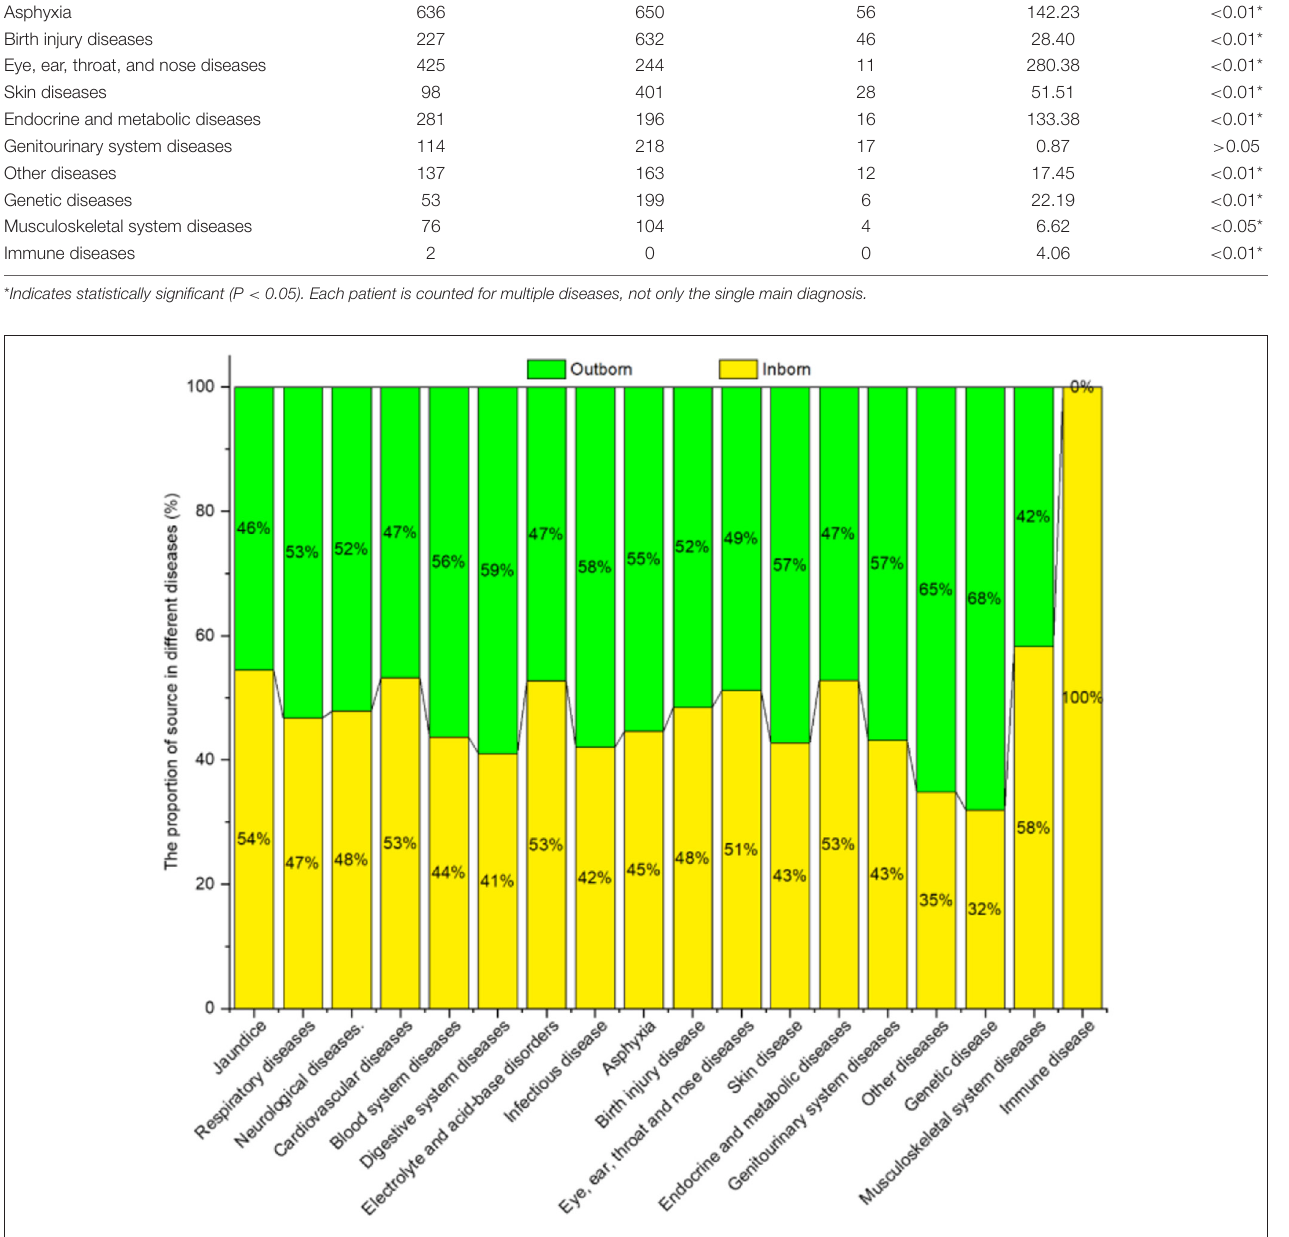
FIGURE 12 | Neonatal diseases and distribution by patient